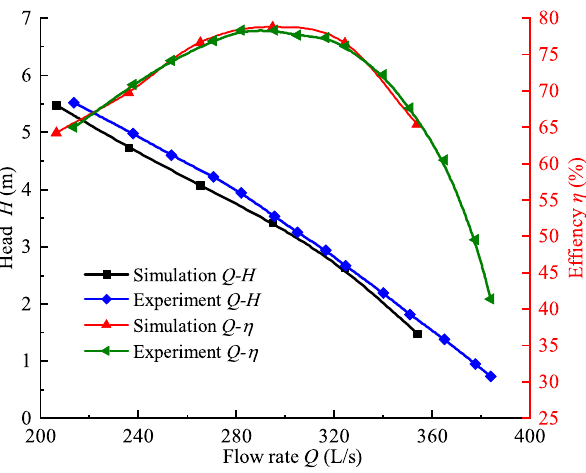
Figure 5. Energy test